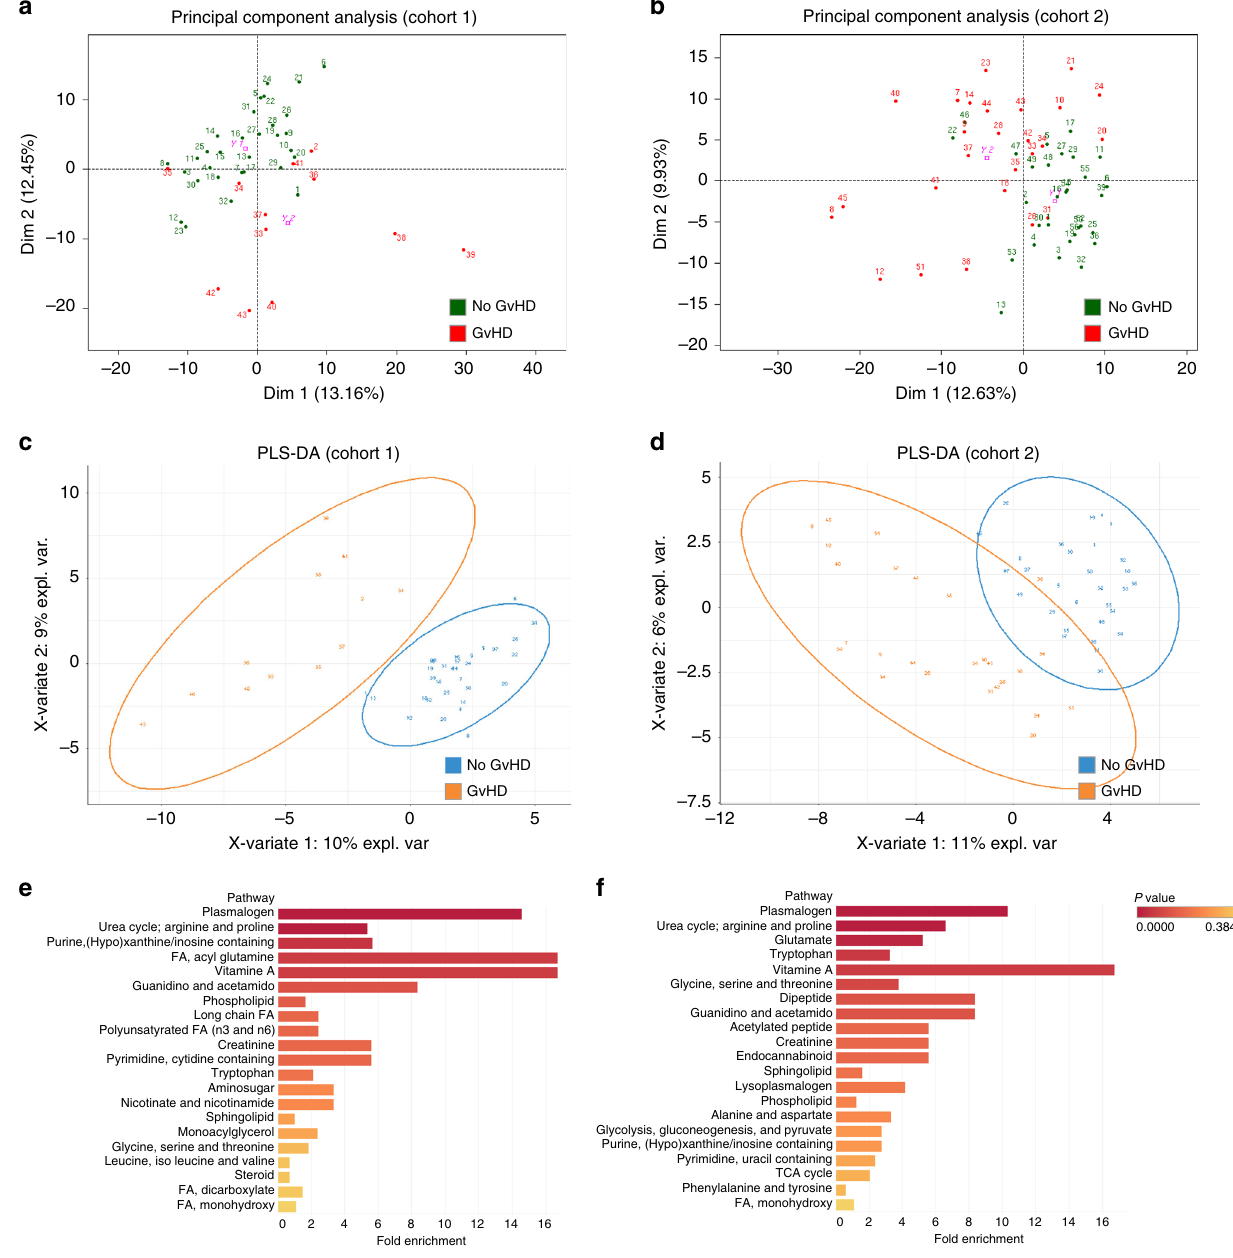
Fig. 6 Identi fi cation of main pathways involved in aGVHD using multivariate analysis. Principal component analysis was able to discriminate recipient with (red) or without (green) GvHD in dimension 1 for cohort 1 ( a ) and 2 ( b ). Sparse partial least square discriminant analysis (sPLS-DA) was then used to identify metabolites that mostly contribute to the discrimination of patients with (orange) or without GvHD (blue) for cohort 1 ( c ) and 2 ( d ). Complete list of metabolites is available in Supplementary Data 14. These metabolites were then used to identify main pathways involved in acute GvHD using overrepresentation analysis for cohort 1 ( e ) and 2 ( f